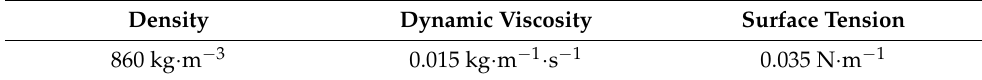
Table 1. Physical properties of the oil.